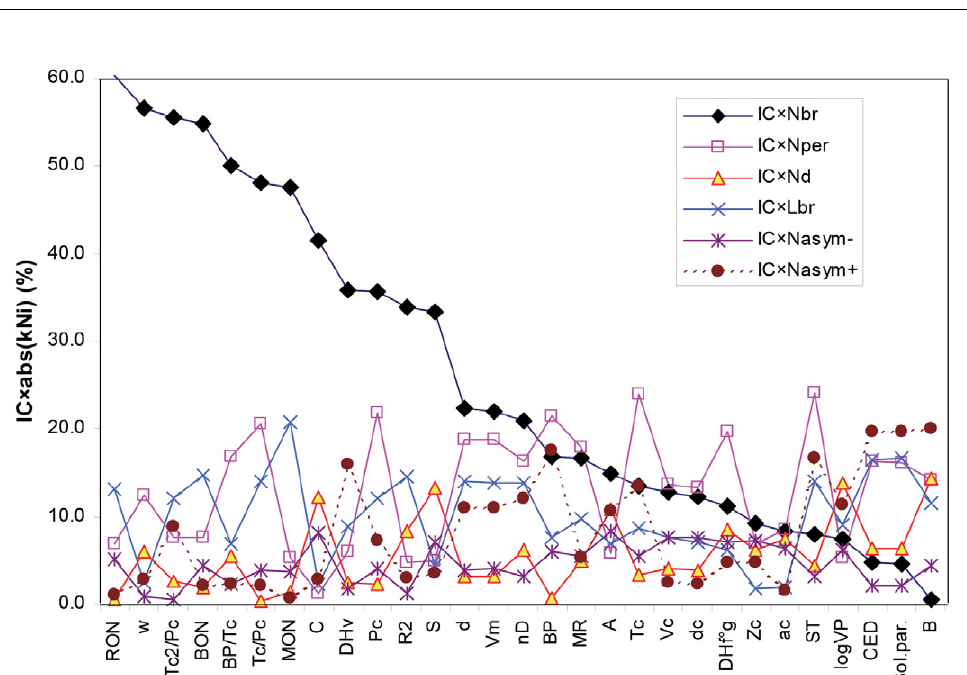
Figure 1. Information contribution of the Structural Numbers N br , N per , N d , L br , N asym ↔ , and N asym ^ about the values of physicochemical properties of octanes as measured by the product IC ×|k Ni | (%) and sorted by the contribution of the Number of